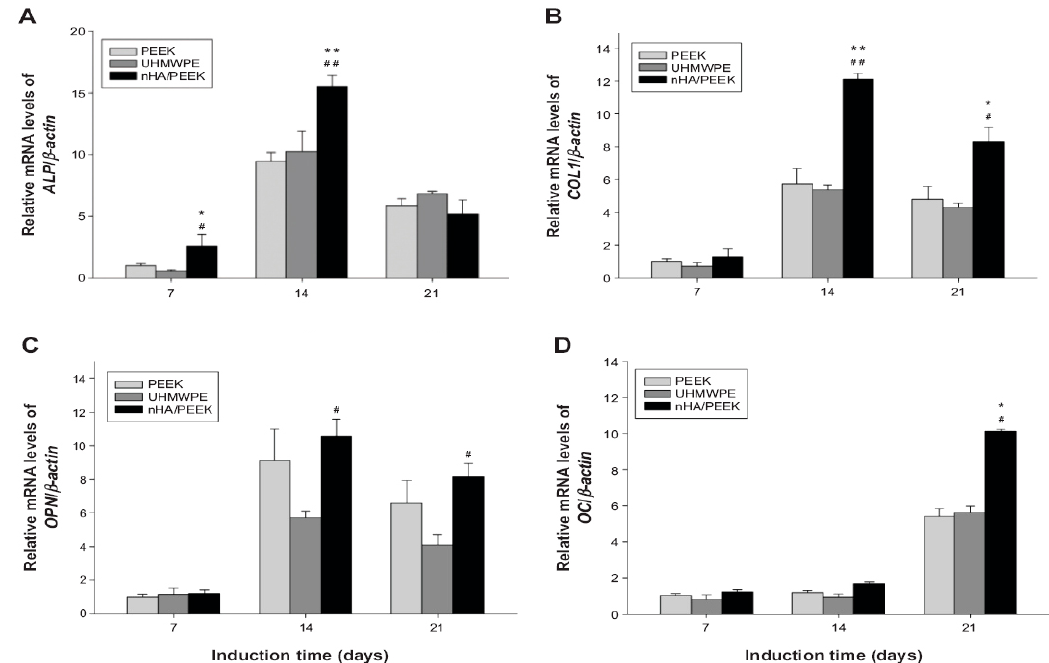
Figure 17. Differentiation of MC3T3-E1 cells on PEEK, UHMWPE and PEEK/40wt% nHA samples determined by real-time polymerase chain reaction: ( a ) ALP, ( b ) COL1, ( c ) OPN, and ( d ) OC gene expressions. *Significant difference compared with PEEK ( p < 0.05); **significant difference compared with PEEK ( p < 0.01); #significant difference compared with UHMWPE ( p < 0.05); ##significant